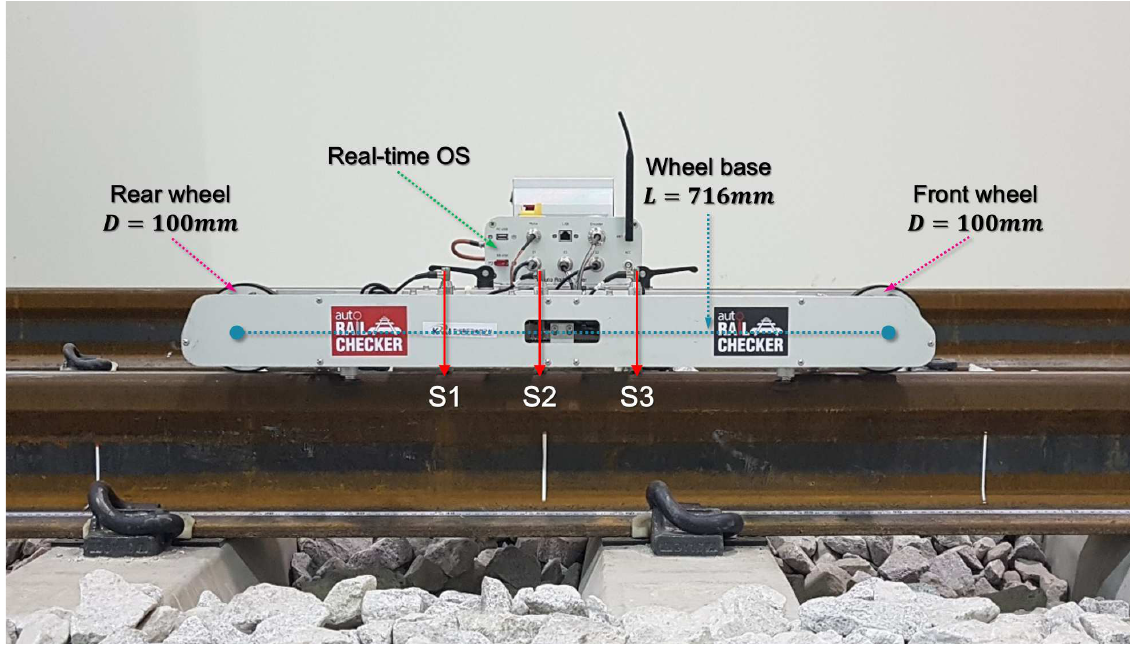
Figure 8. Auto Rail Checker (ARCer) for measuring the longitudinal railhead profile.